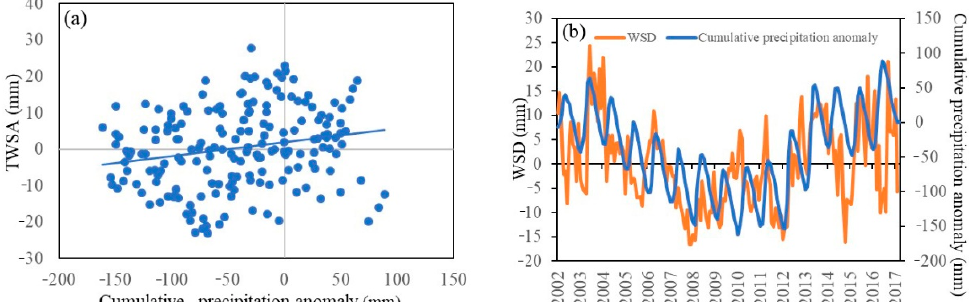
Figure 7. The correlation between TWSA and cumulative precipitation anomaly ( a ), and the series of WSD and cumulative precipitation anomaly ( b ).